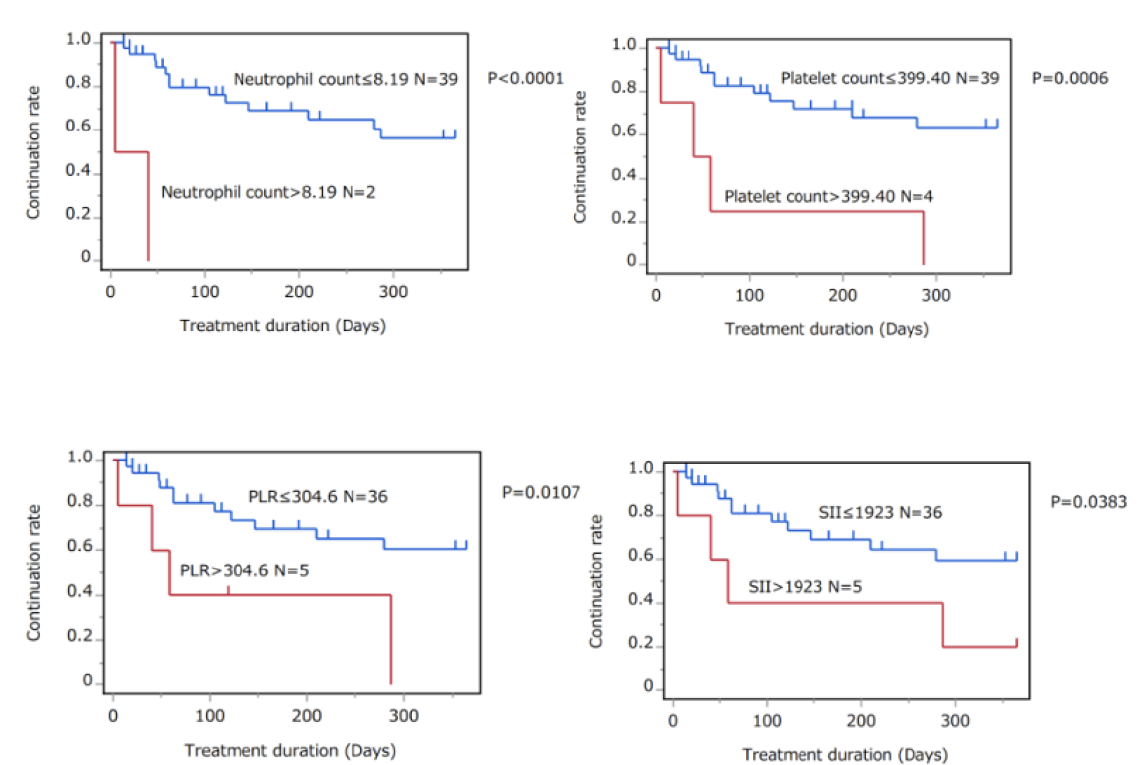
platelet-to-lymphocyte ratio; SII, systemic immuno-inflammatory index; SIRI, systemic inflammatory response index; CRP, C-reactive protein.